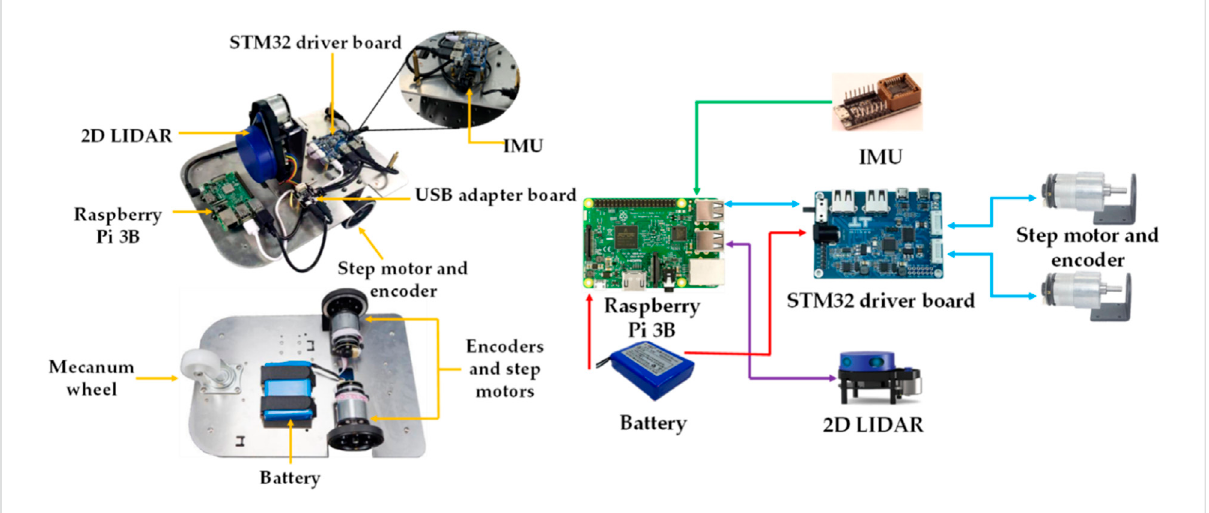
FIGURE 1 Hardware and software structure of the 3D imaging